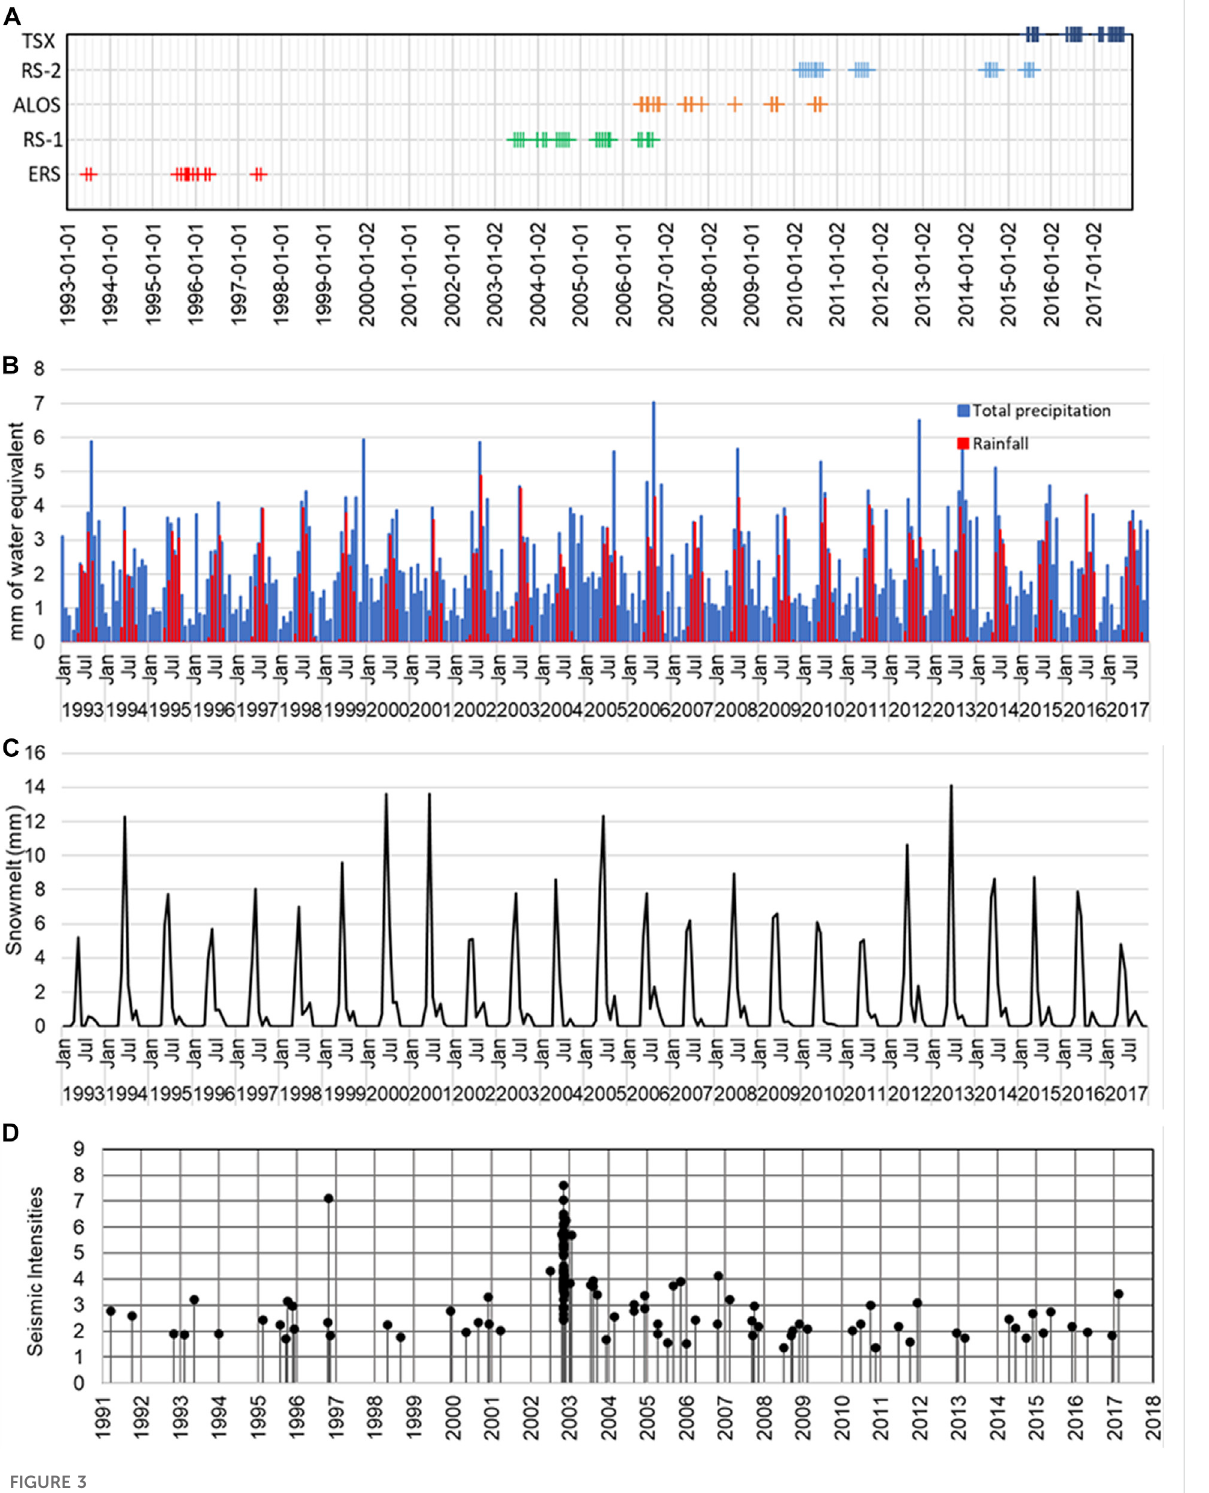
FIGURE 3 Overview of datasets, with (A) satellite data acquisition dates, (B) monthly average precipitation and the rainfall partition (mm of water equivalence (WE)), (C) monthly average snowmelt (mm of WE) and (D) local seismic